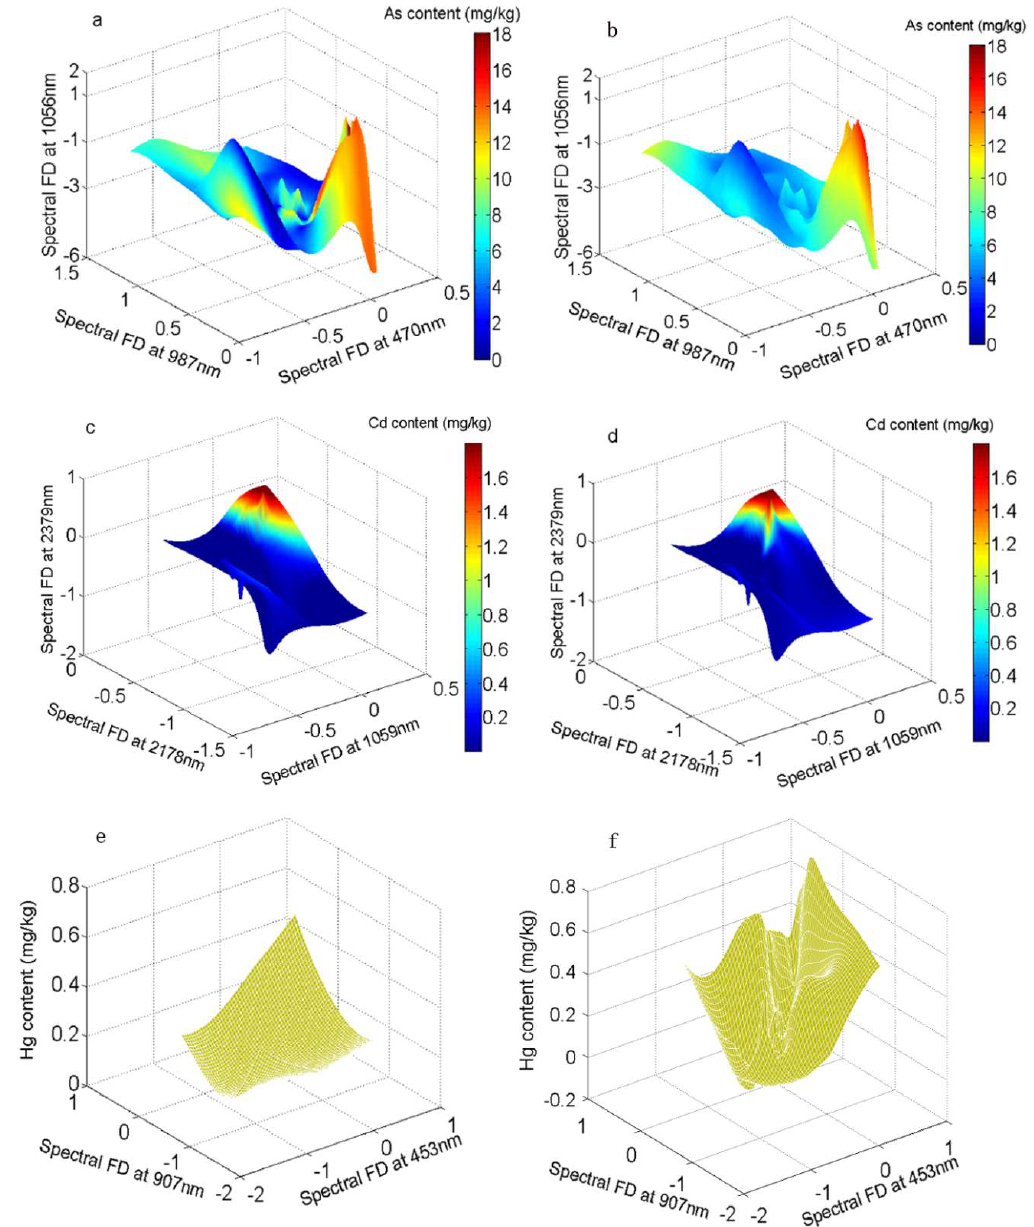
Figure 7. Comparison of soil heavy metal content between the model predicted and field measured values in terms of surfaces by cubic spline interpolation based on: ( a ) field measured data versus ( b ) model predicted values for As; ( c ) field measured data versus ( d ) model predicted values for Cd; and ( e ) field measured data versus ( f ) model predicted values for Hg. Table 3. The accuracy of the model fitting based on the field measurements of the soil heavy metal content from the 65 training soil samples.